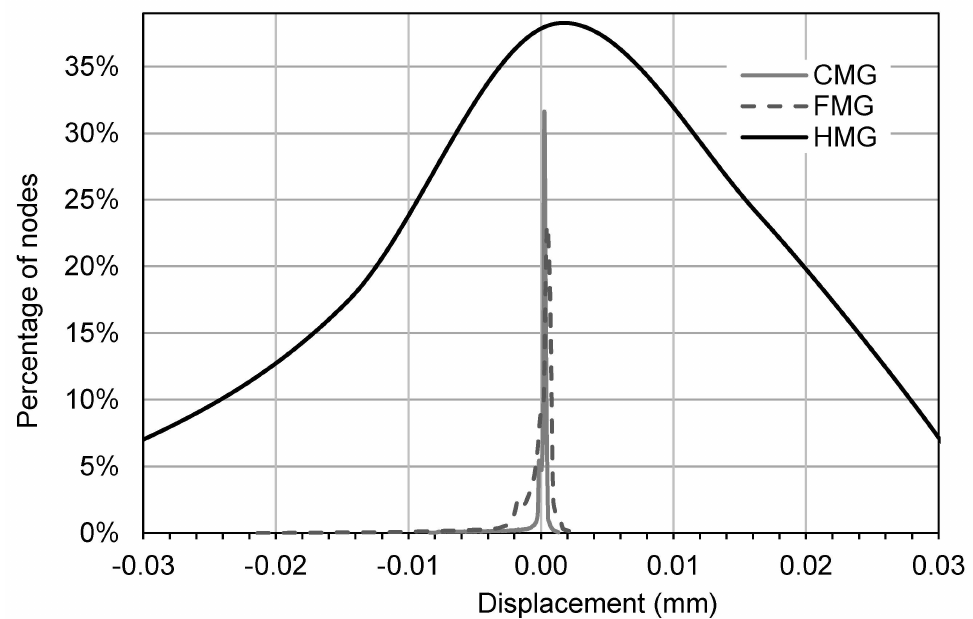
Figure 4. Histograms of the distributions found for the movement antero-posterior, i.e., in the direction of the x-axis, in all mouthguards.